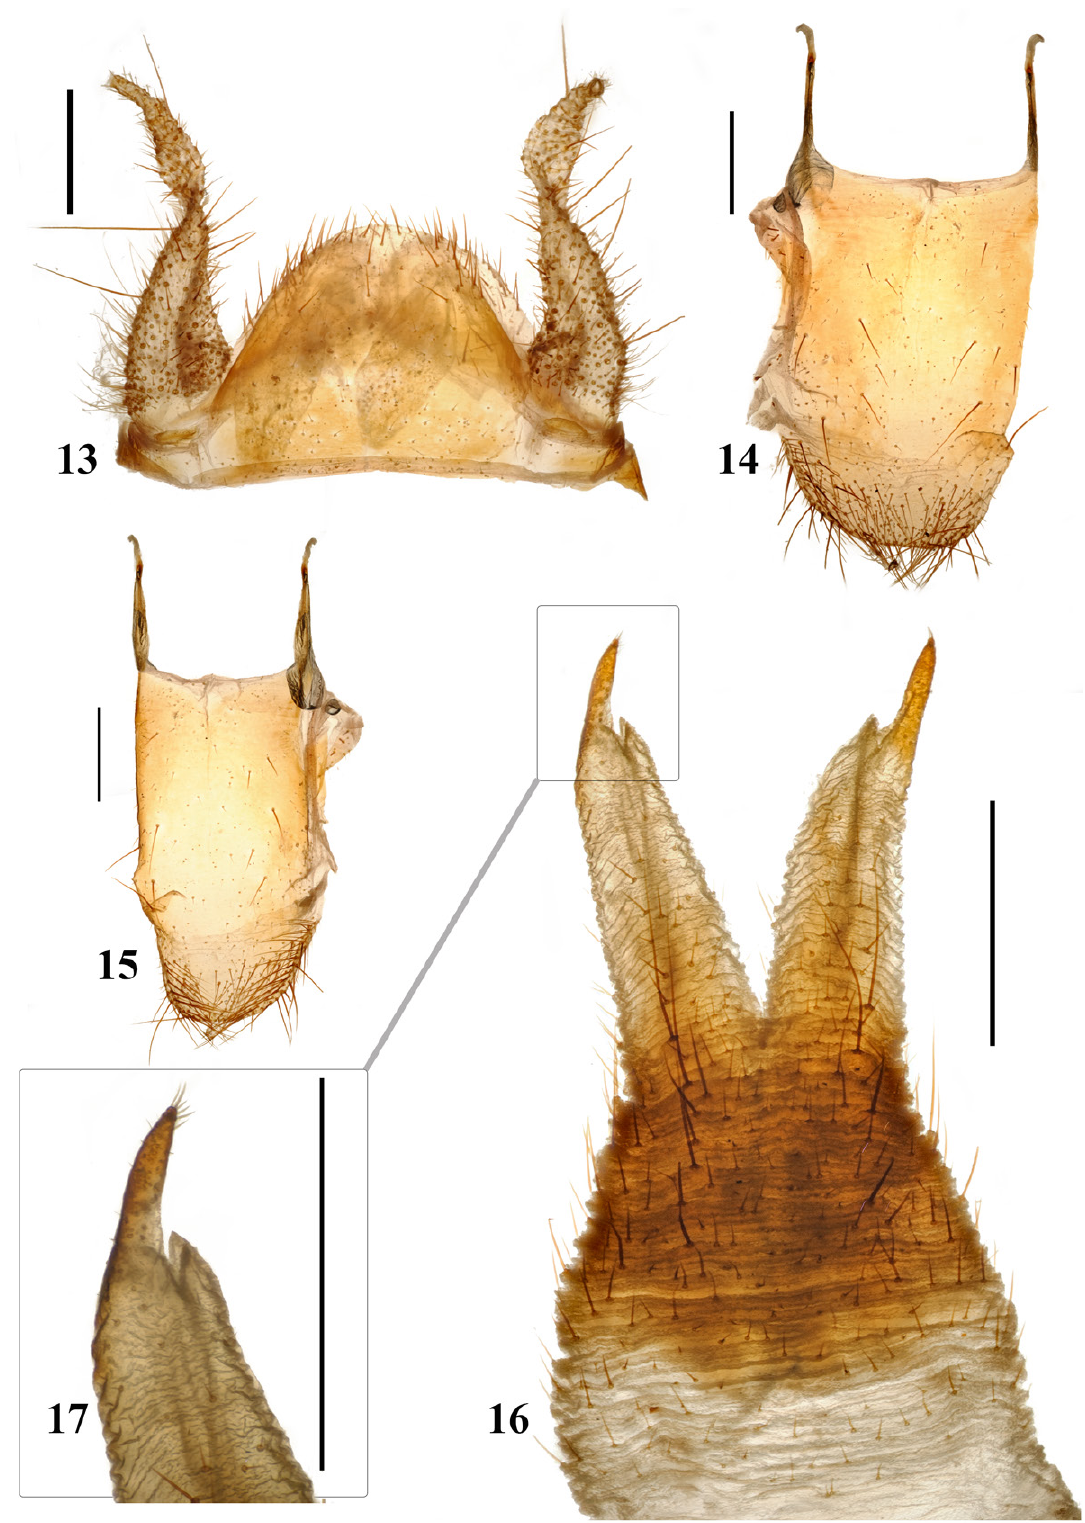
Figs 13–17. Oryctopterus varuna sp. nov. Paratype, ♂ (NBAIR). 13 . Supragenital plate and cerci. 14 . Subgenital plate, dorsal view. 15 . Subgenital plate, ventral view. 16 . Genital hook and associated structures, ventral view. 17 . Genital hook. Scale bars = 1